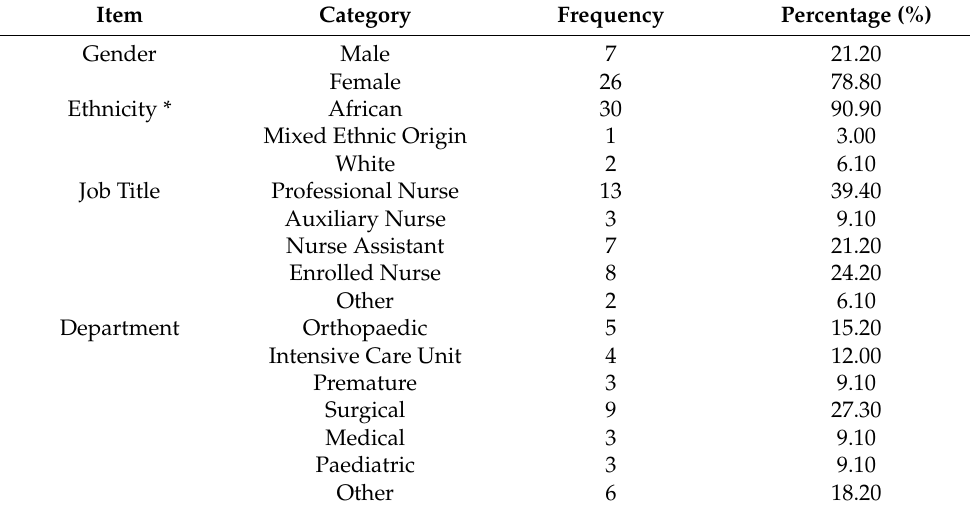
Table 1. Characteristics of the participants ( n =